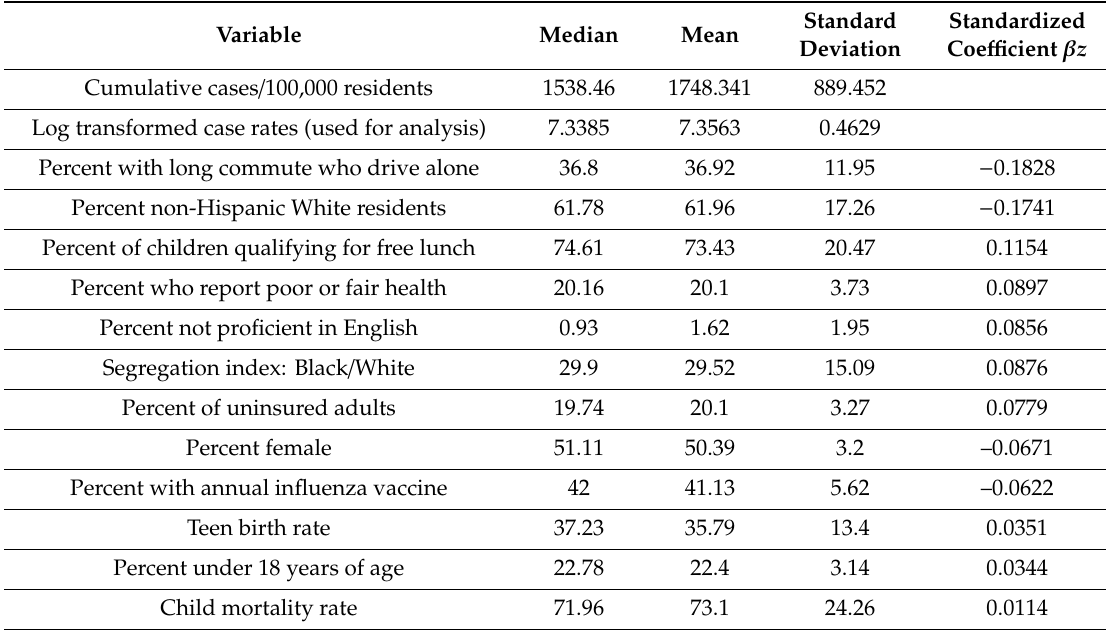
Table 1. Descriptive statistics for case rates and all independent variables chosen by lasso